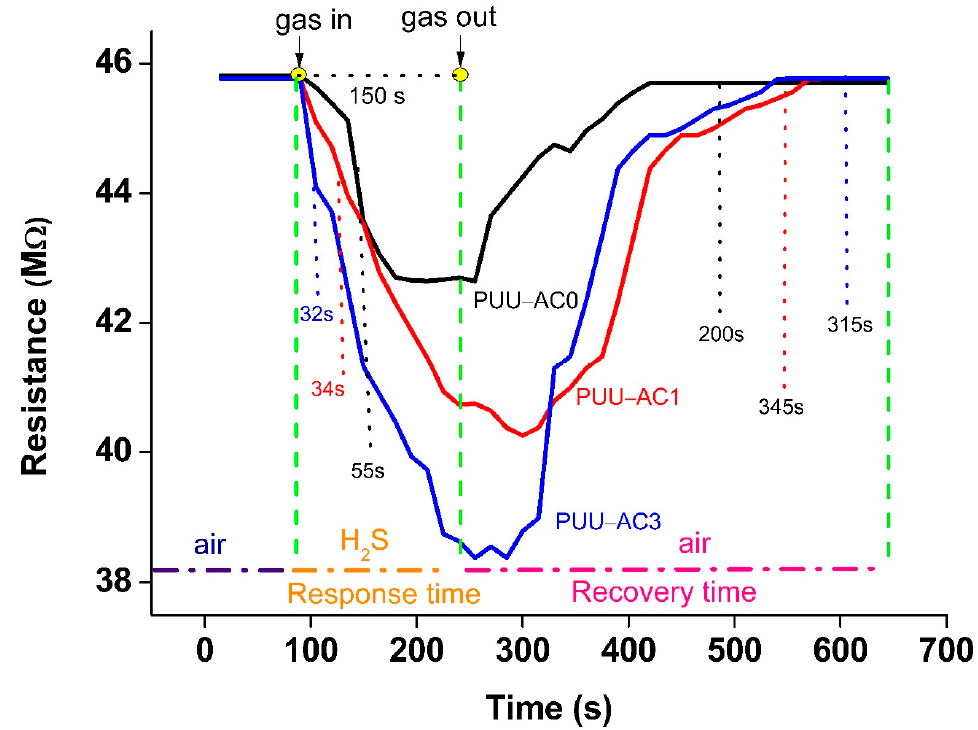
Figure 8. Dynamic-response–recovery-time curves of ITO sensors, based on PUU-AC0,